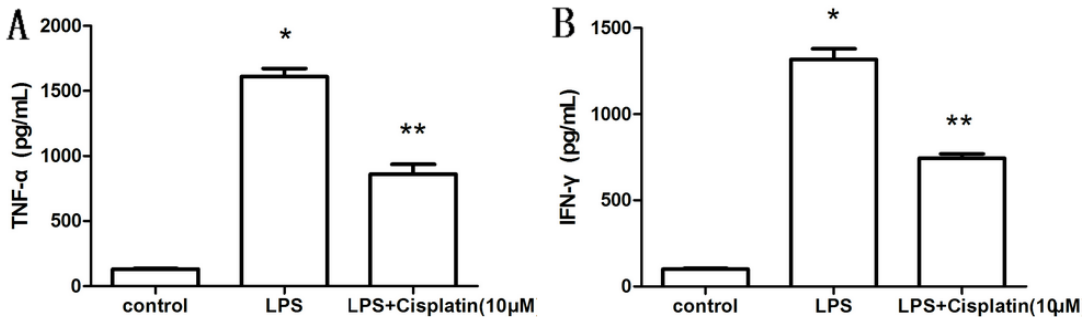
Figure 2. Effect of cisplatin on TNF- α and IFN- γ in macrophage-like cells. ( A ) TNF- α level; ( B ) IFN- γ level. Compared with the control group, * p < 0.05; compared with the LPS-treated group, ** p < 0.05. Results are expressed as the mean ± SD ( n =